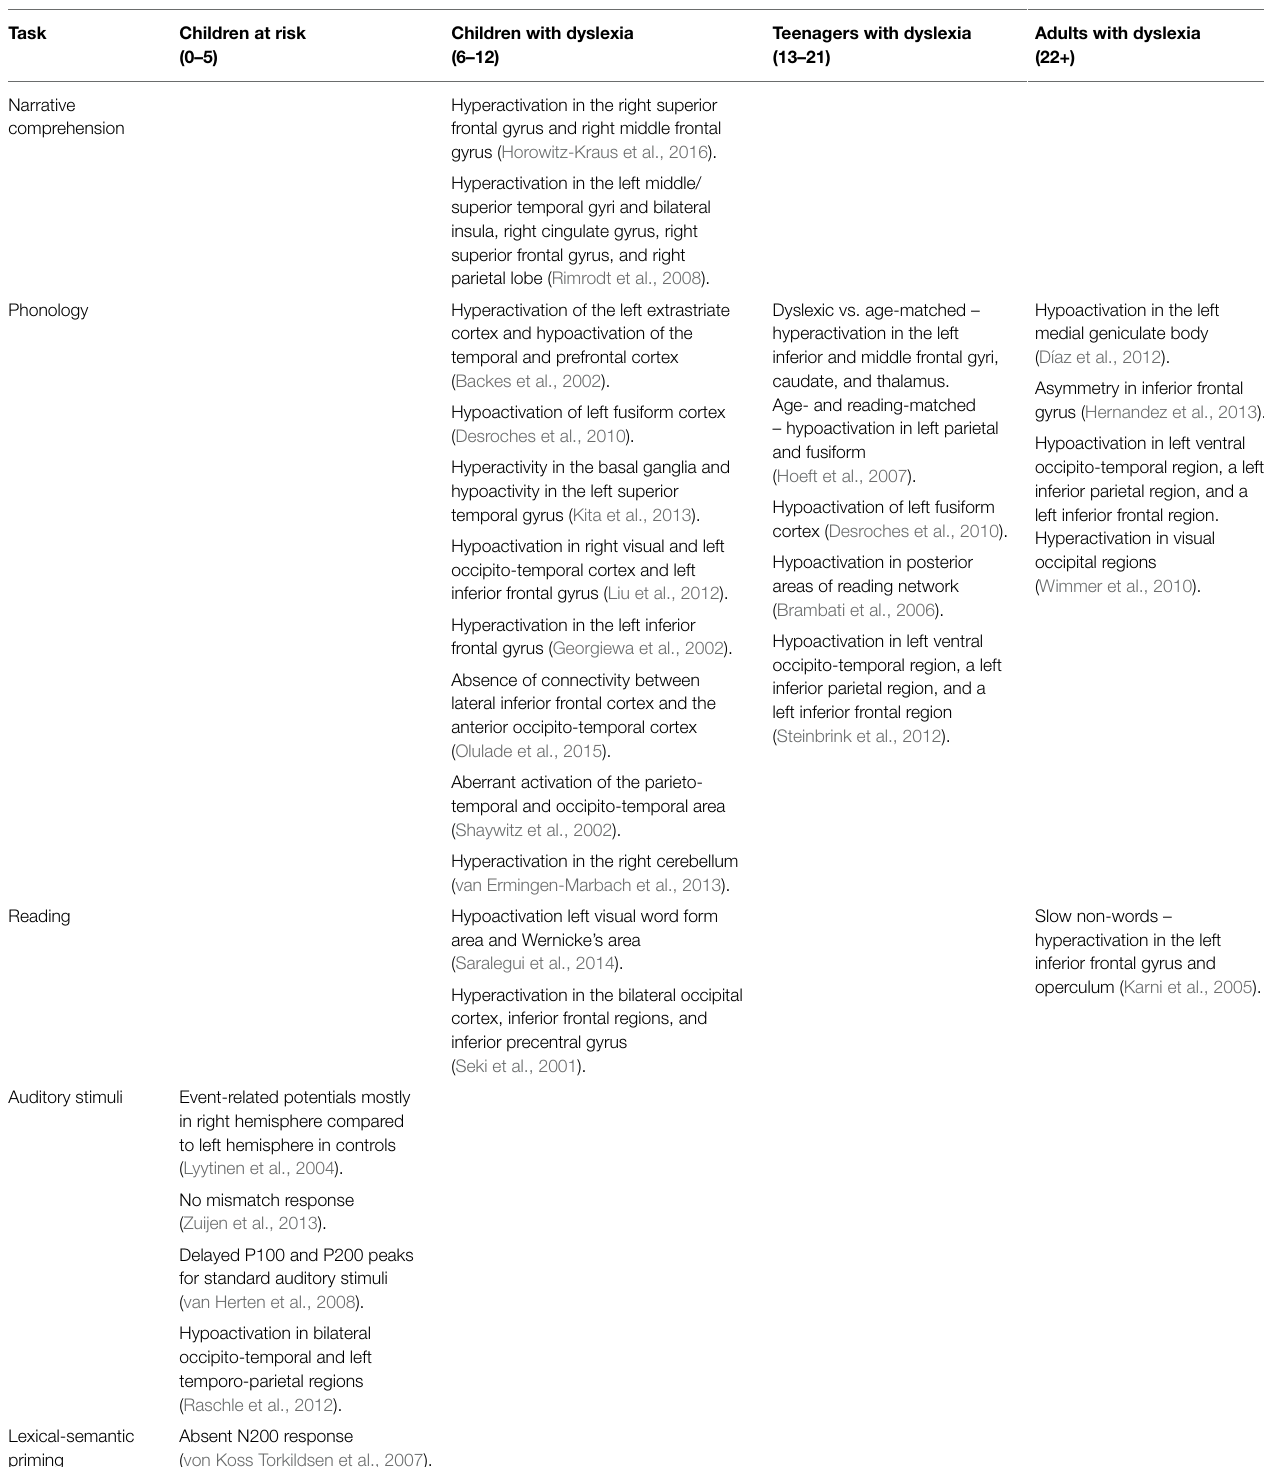
TABLE 2 | Summary of studies assessing neurobiological changes during reading-related tasks along